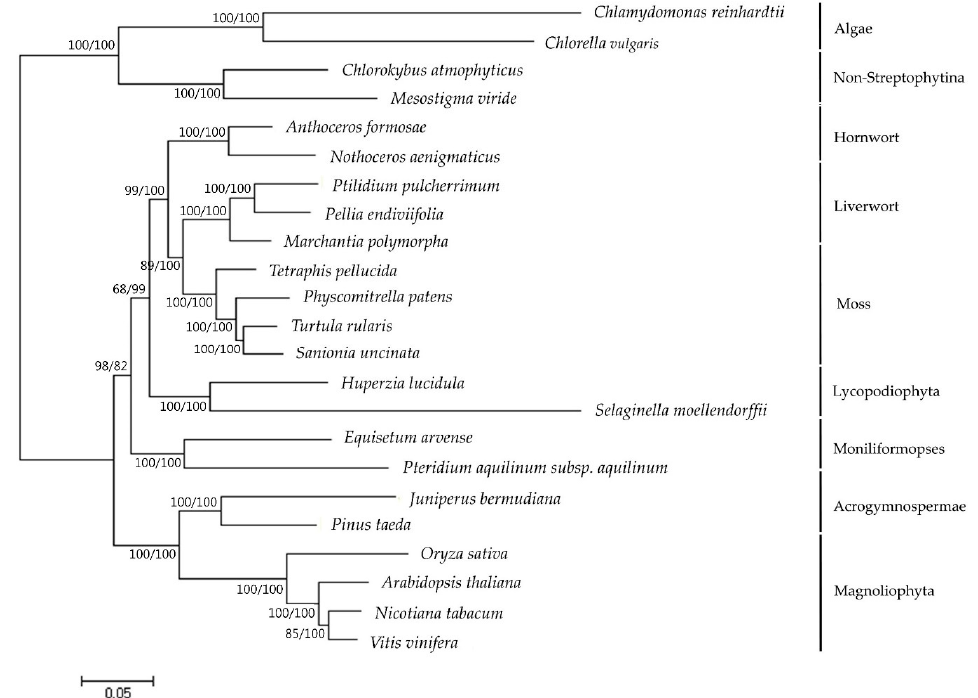
Figure 3. Phylogenetic tree reconstruction of 23 taxa using MEGA7 based on concatenated sequences of 40 protein-coding genes in the plastome. Maximum likelihood (ML) topology is shown with the bootstrap support values (MP/ML) given at nodes. Forty protein-coding sequences were extracted from annotated plastomes found in GenBank [21] (http://www.ncbi.nlm.nih.gov) (Table S2). The nucleotide sequences for each gene were translated into amino acids, aligned in MEGA7 and manually adjusted. Nucleotide sequences were aligned by constraining them to the amino acid sequence alignment. Individual gene alignments were then assembled into a single dataset.